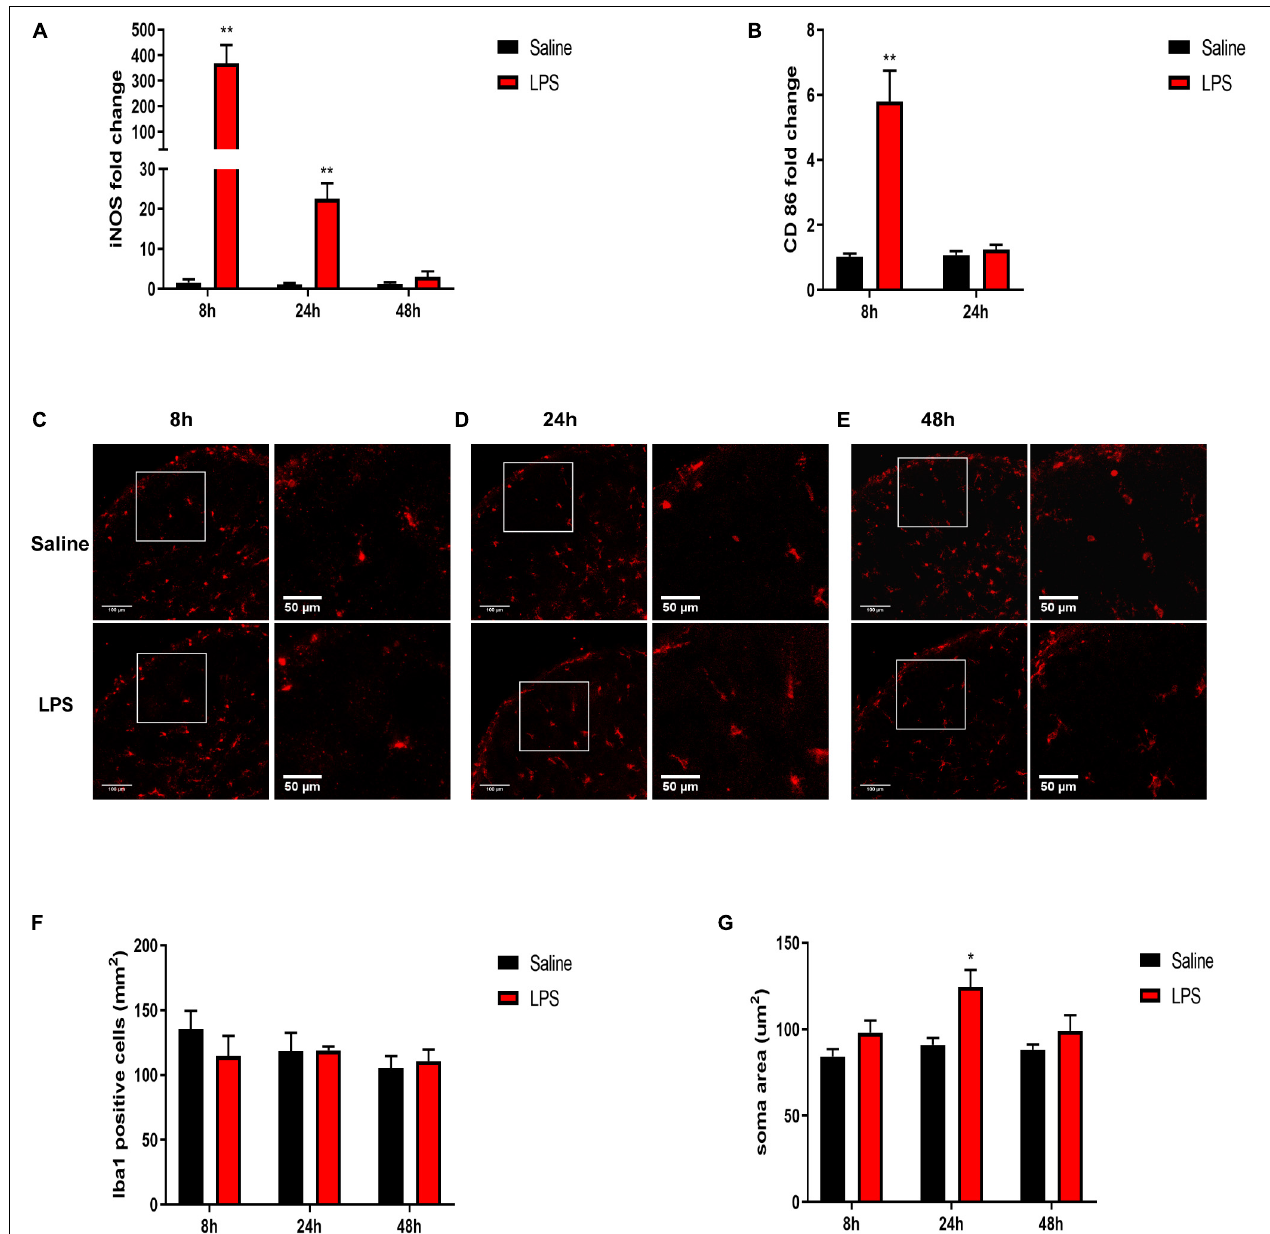
FIGURE 4 | Effects of systemic injection of LPS on M1 microglial markers, microglial number, and morphology in the spinal cord of neonatal rats. (A) mRNA level of iNOS was elevated 8 and 24 h after LPS injection in neonatal rats. (B) mRNA level of CD86 was elevated 8 h after LPS injection in neonatal rats. (C–E) Representative photomicrographs of Iba1 immunostaining in the rat spinal cord dorsal horn 8, 24, and 48 h after saline or LPS injection. Scale bars, 100 and 50 µ m for the inset images. (F) Systemic LPS exposure did not change Iba1-positive cell numbers 8, 24, and 48 h after LPS injection. (G) Systemic LPS exposure induced enlarged soma size of Iba1-positive microglia 24 h after injection. Results are expressed as the mean ± SEM, n = 4–5 animals for each group, and were analyzed by unpaired t -test or Mann–Whitney test. * P < 0.05, ** P < 0.01. LPS group vs. Saline group.